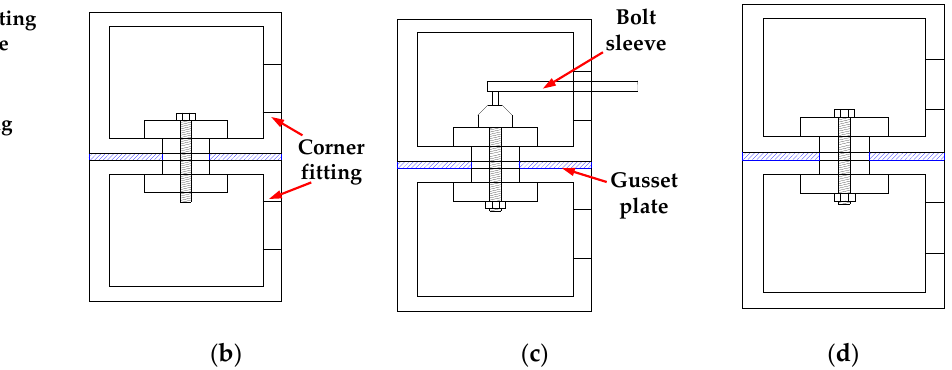
Figure 4. Diagram of the assembly process: ( a ) align vertically; ( b ) match locating hole; ( c ) fasten vertical bolt; and ( d ) complete connection.